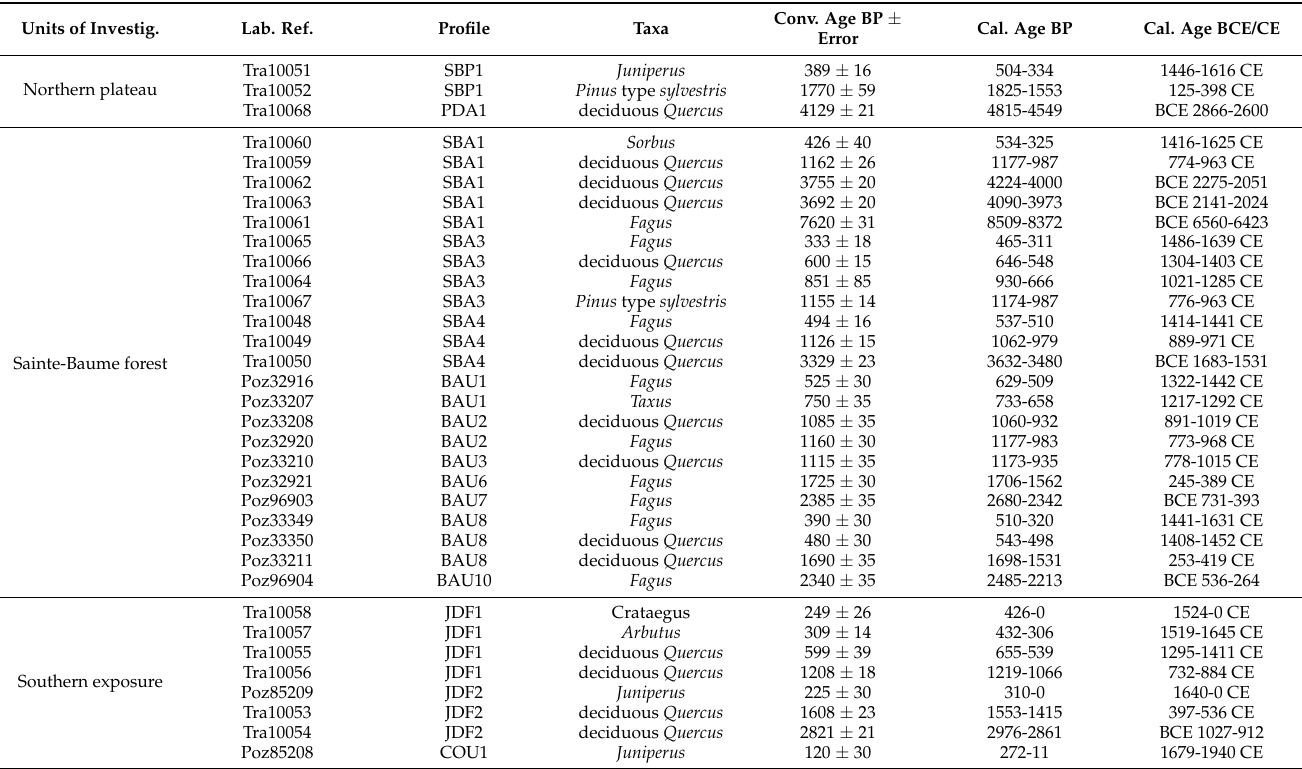
Table 3. Dates of charcoal pieces obtained by 14C accelerator mass spectrometry (AMS) calibrated with a two-standard- deviation (2 σ ) 95% confidence interval on the OxCal program [60] with the IntCal20 dataset [61]. Units of